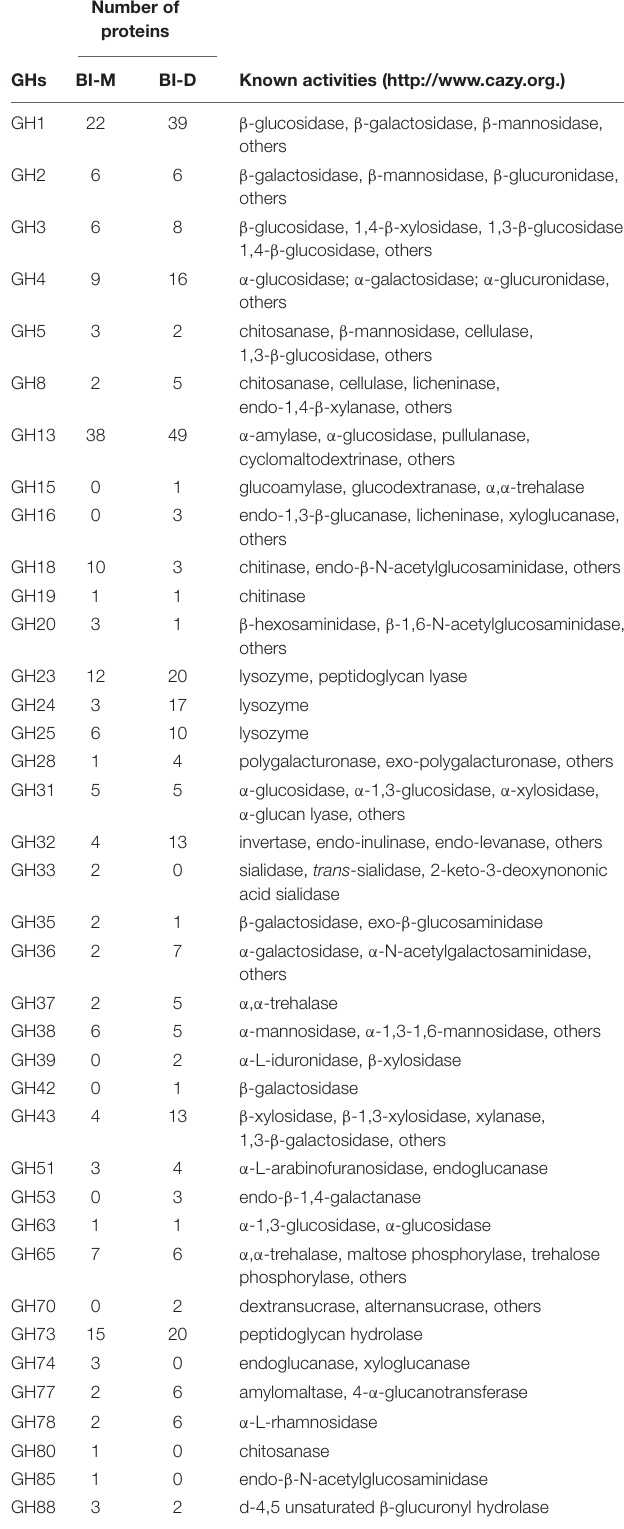
TABLE 1 | A partial list of CAZymes identified in the microbial consortia from the ECB larvae fed with an artificial diet (BI-D) or maize plants (BI-M) Number of proteins